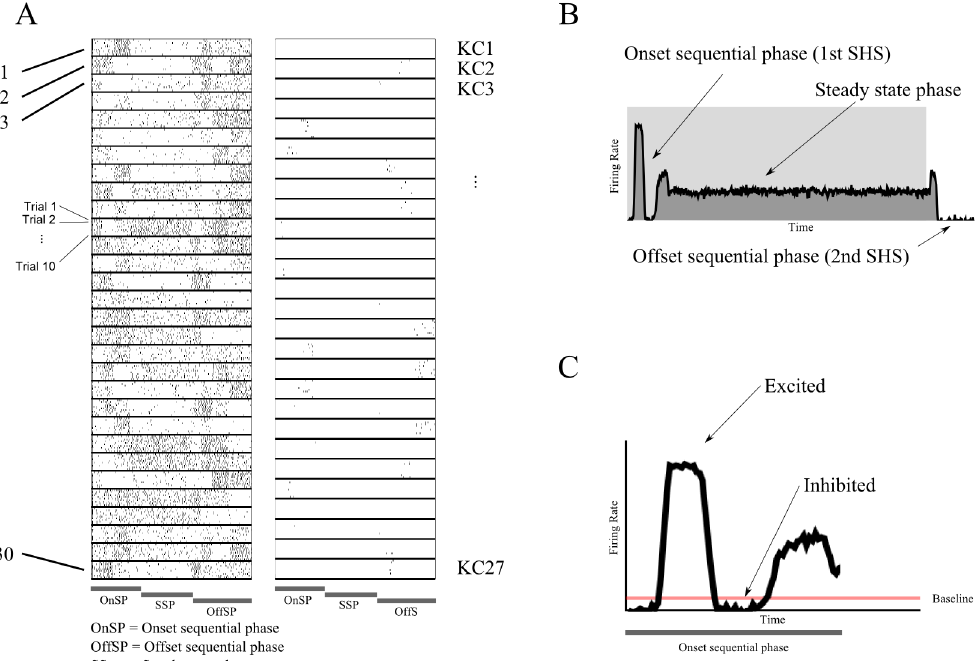
Fig 3. Illustration of experimental findings. (A) Raster plots for the full response (three phases) to a stimulus of PNs (left) and KCs (right) using a modified version of the generative model (see Methods for details; also see the S1 Text). This modified version was only used for the generation of this figure and no inversion was performed on it. Although the model consisted of 30 PNs and 100 KCs, most KCs were inactive during the simulations. Only the 27 active KCs are shown. The simulation was run for ten trials and the responses of different neurons are separated by thick black lines. For the PNs, periods of inhibition and excitation can be observed. During the steady state phase the population no longer evolved. KC responses are very sparse, with only a few spikes per KC throughout a trial. (B) Instantaneous firing rate for a sample PN. (C) The periods of excitation and inhibition (with respect to a baseline) during the dynamic phase for the PN in B. The baseline shown is calculated as half the minimum PN activity that the generative model can produce before it is zero.